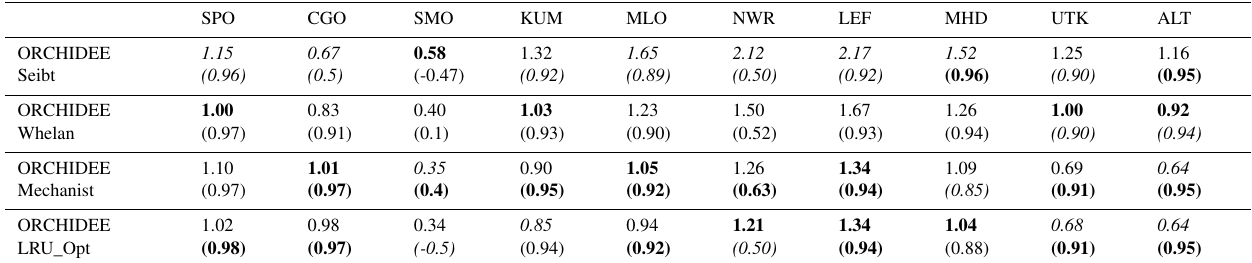
Table 6. Normalised standard deviations (NSDs) of the simulated concentrations by the observed concentrations. Within brackets are the Pearson correlation coefficients ( R ) between simulated and observed COS concentrations for the mechanistic and LRU approaches, calculated between 2004 and 2009 at 10 NOAA stations. For each station, NSD and R closest to 1 are in bold and the farthest ones are in italic. The time series have been detrended beforehand and filtered to remove the synoptic variability (see Sect. 2.2.4). SPO CGO SMO KUM